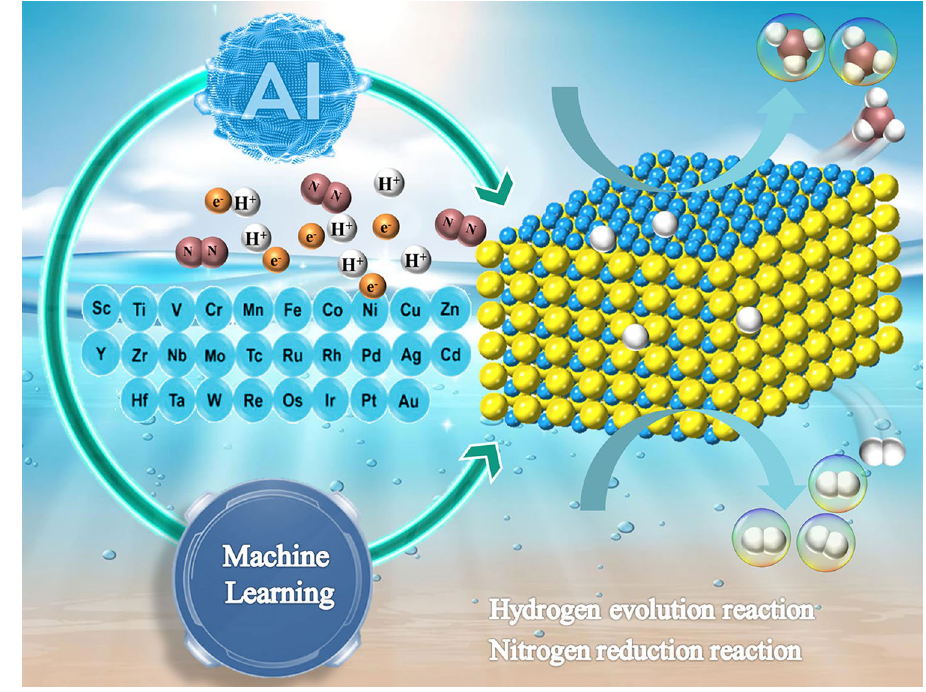
Fig. 11 Machine learning has become a powerful tool for the design and screening of novel catalysts for HER and